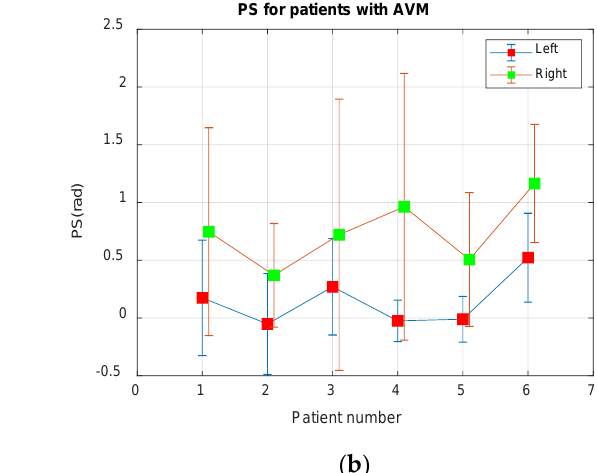
Figure 1. The example of the dependences of the phase shift between the BP and BFV signals in the left and right middle cerebral arteries against the background of the magnitude-squared coherence between the signals on time and pseudo-frequency: ( a ) For a healthy volunteer on one side; ( b ) For a patient with an arteriovenous malformation in the left middle cerebral artery on the AVM side.